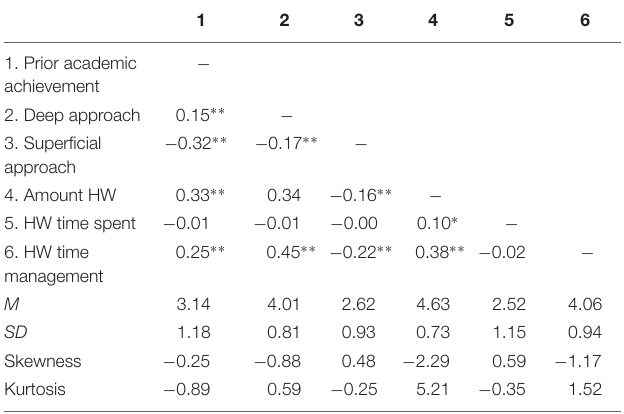
TABLE 1 | Means, standard deviations, skewness, kurtosis, and correlation matrix of the target variables.